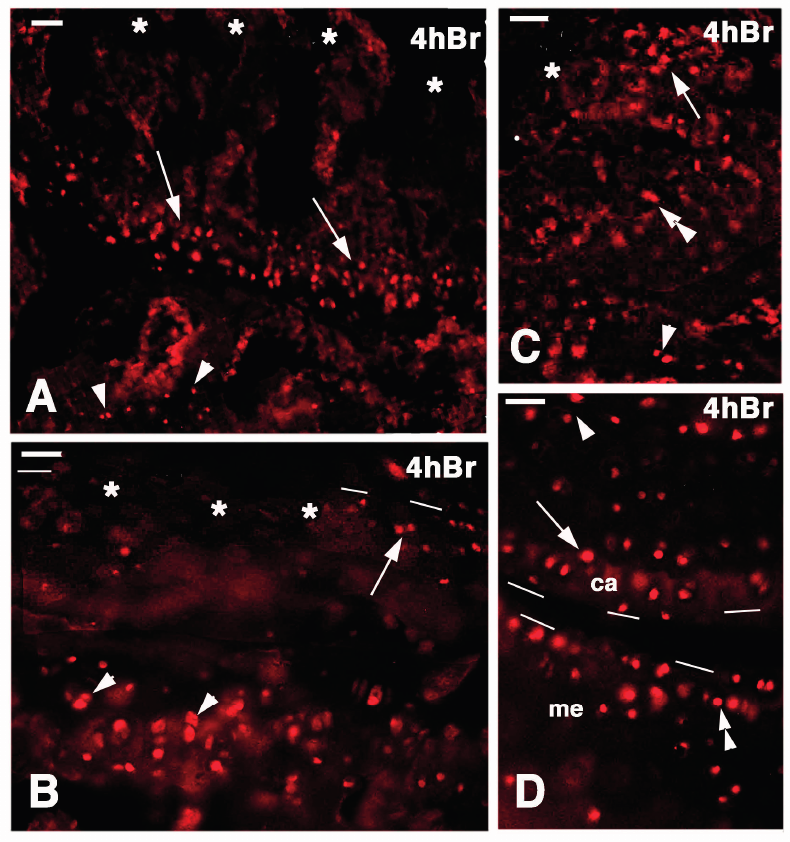
Figure 7. Immunolocalization of labeled cells in 4-day lesioned knee epiphyses at 4 h post-injection of 5BrdU. Dashes outline the perimetry of the articular cartilage. ( A ) Numerous labeled cells (arrows) are still seen in the metaphyseal plate but not in the damaged superficial articular cartilage (asterisks). Arrowheads point to sparse labeled cells in the bone marrow of the diaphysis. Bar, 25 µm; ( B ) Detail of the labeled cells (arrowheads) present in the serial cartilage of the metaphysis that are absent in the superficial, damaged cartilage (asterisks) but are still seen in a confining region of relatively undamaged cartilage (arrow). Bar, 25 µm; ( C ) Area of relatively undamaged cartilage showing the presence of still labeled cells in the superficial part of the articular cartilage (arrow, the asterisk indicates the nearby damaged area). Sparse labeled cells are located in the intermediate region (double arrowhead) and by the metaphyseal plate (arrowhead). Bar, 25 µm; ( D ) Intact area of femur articular cartilage (ac) showing labeled cells (arrow), near the metaphyseal serial cartilage (arrowhead), and in the meniscus (me, double arrowhead). Bar, 25